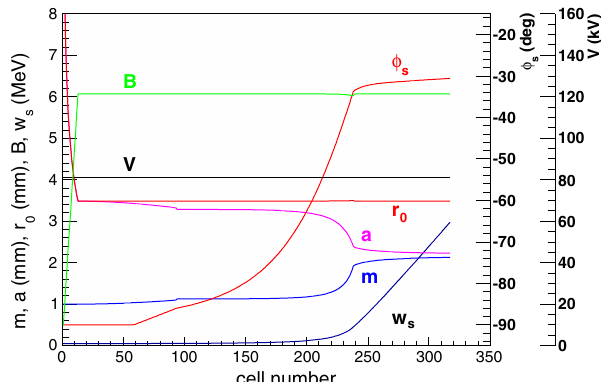
FIG. 1. Cell parameters of RFQ III designed with LINACSrfqDES. The W s means the energy of the synchronous